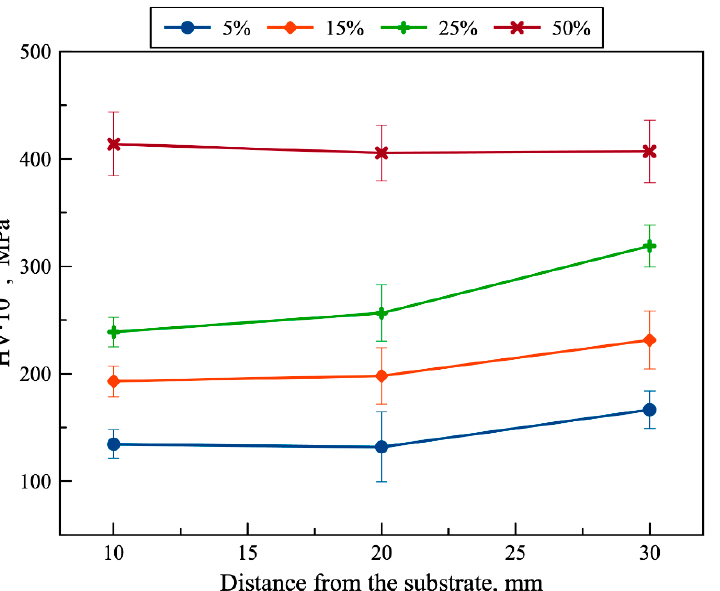
Figure 6. Microhardness values of bronze-based multimaterial composition with different Inconel 625 content. 625